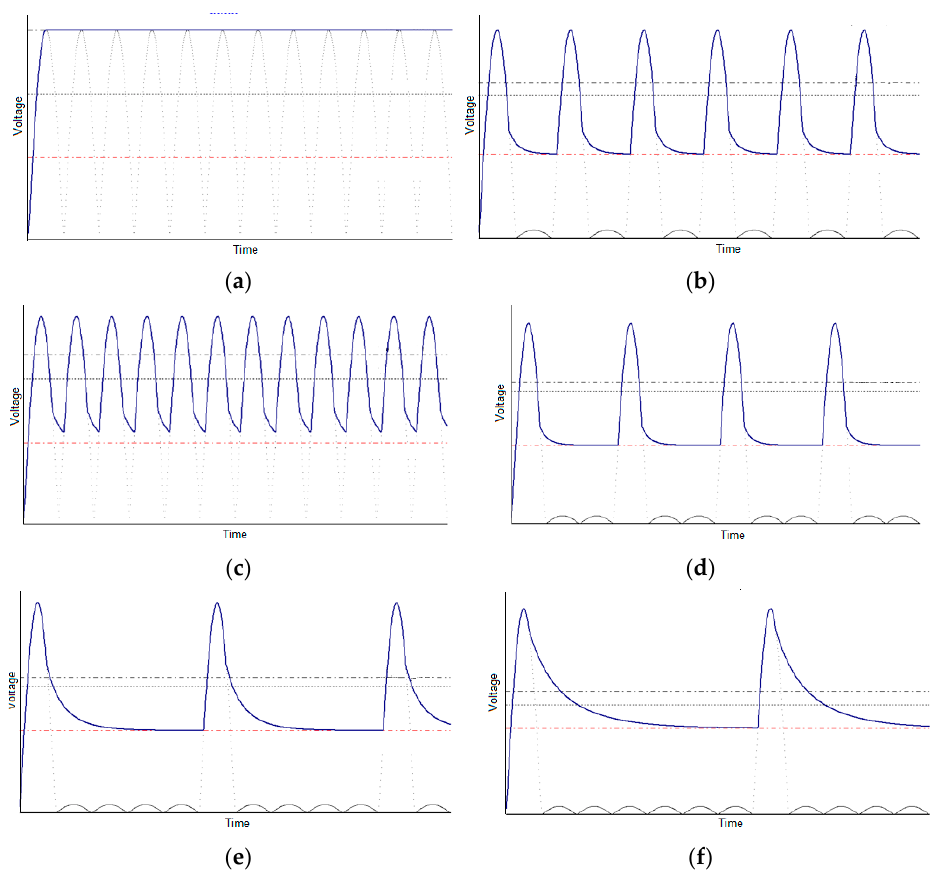
Figure 4. The waveforms of the section voltage at the dust resistivity of 10 12 Ω × cm: ( a ) perfect dc voltage (ideal); ( b ) half ‐ wave rectified voltage; ( c ) full ‐ wave rectified voltage (classical supply); ( d ) 3rd ‐ order intermittent voltage; ( e ) 5th ‐ order intermittent voltage; ( f ) 7th ‐ order intermittent voltage.